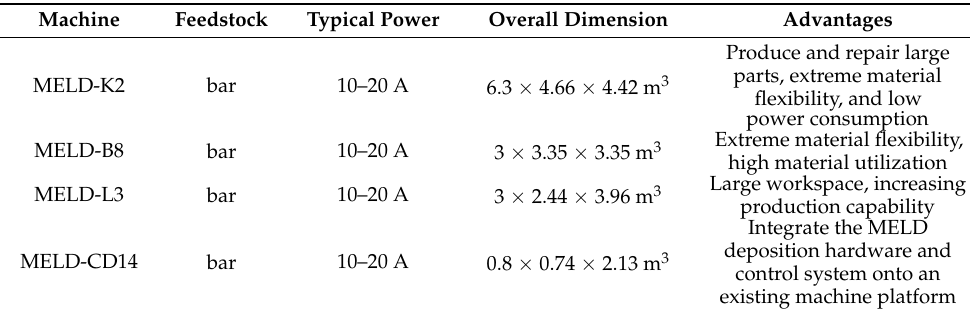
Figure 2. The equipment developed by MELD Corporation [18]. Table 1. The details of different types of equipment. Table 1. The details of different types of